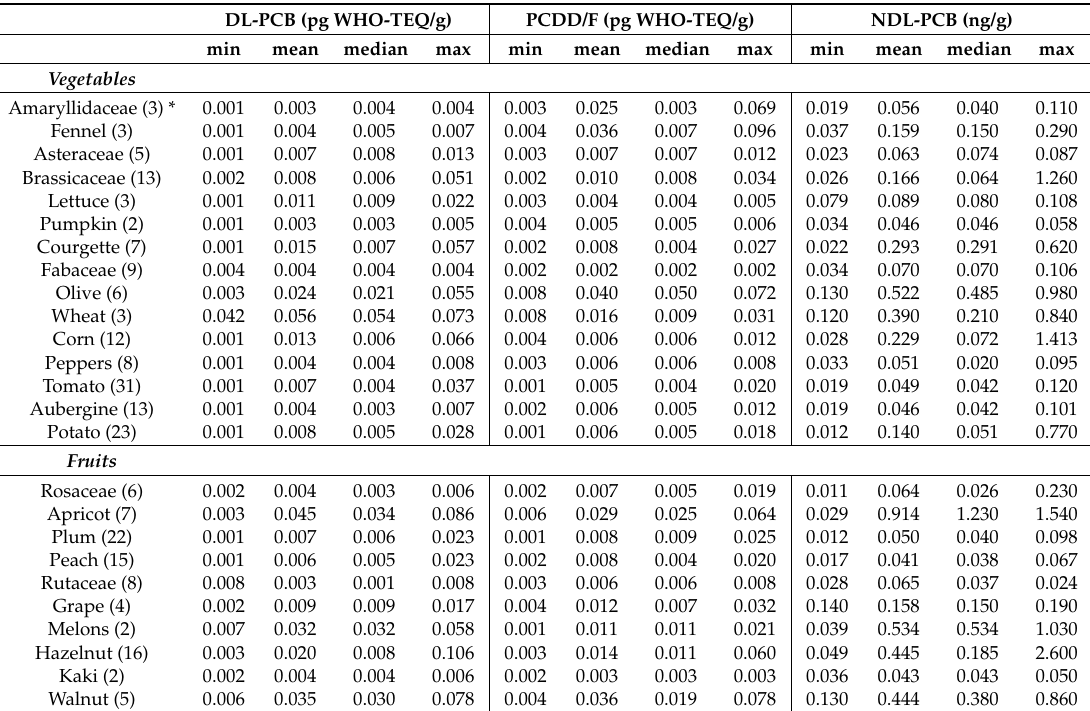
Mean and standard deviation of dioxin-like polychlorinated biphenyls (DL-PCBs), polychlorinated dibenzo- p -dioxins and dibenzofurans (PCDD/Fs), and non-dioxin-like polychlorinated biphenyls (NDL-PCBs) reported as upperbound